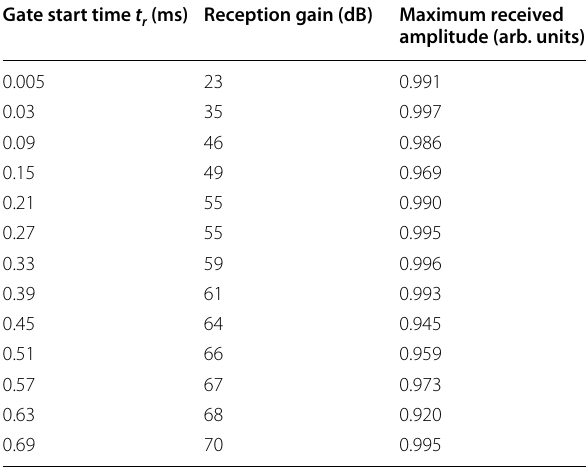
Table 1 Gate start time, reception gain and maximum amplitude corresponding to twelve sets of FMC time traces on the aluminium